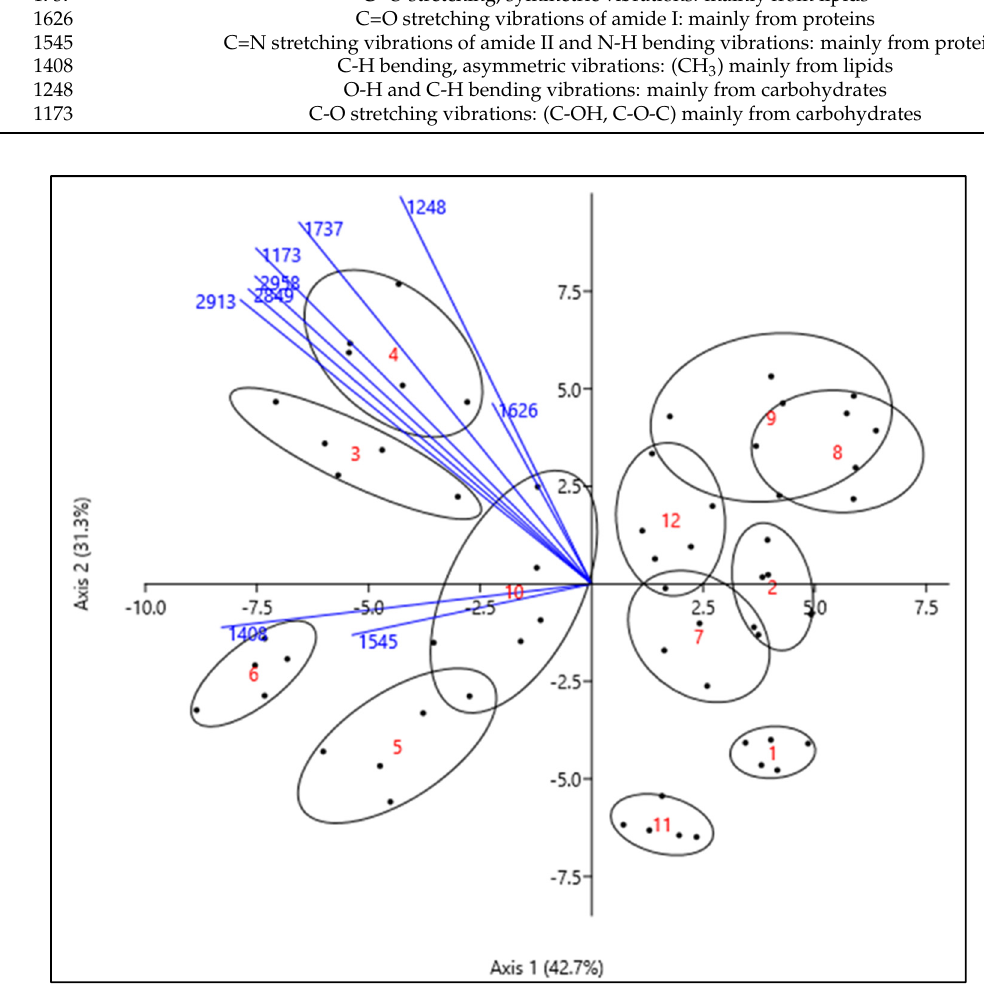
Figure 4. Discrimination analysis (LDA) based on the maximum (peak) absorbance values for the distinguished key ATR-FTIR ranges. The groups are marked with 60% ellipses. Wavenumbers (marked in blue) are explained in Table 1. Numbers from 1 to 12 denote the respective aphid species,